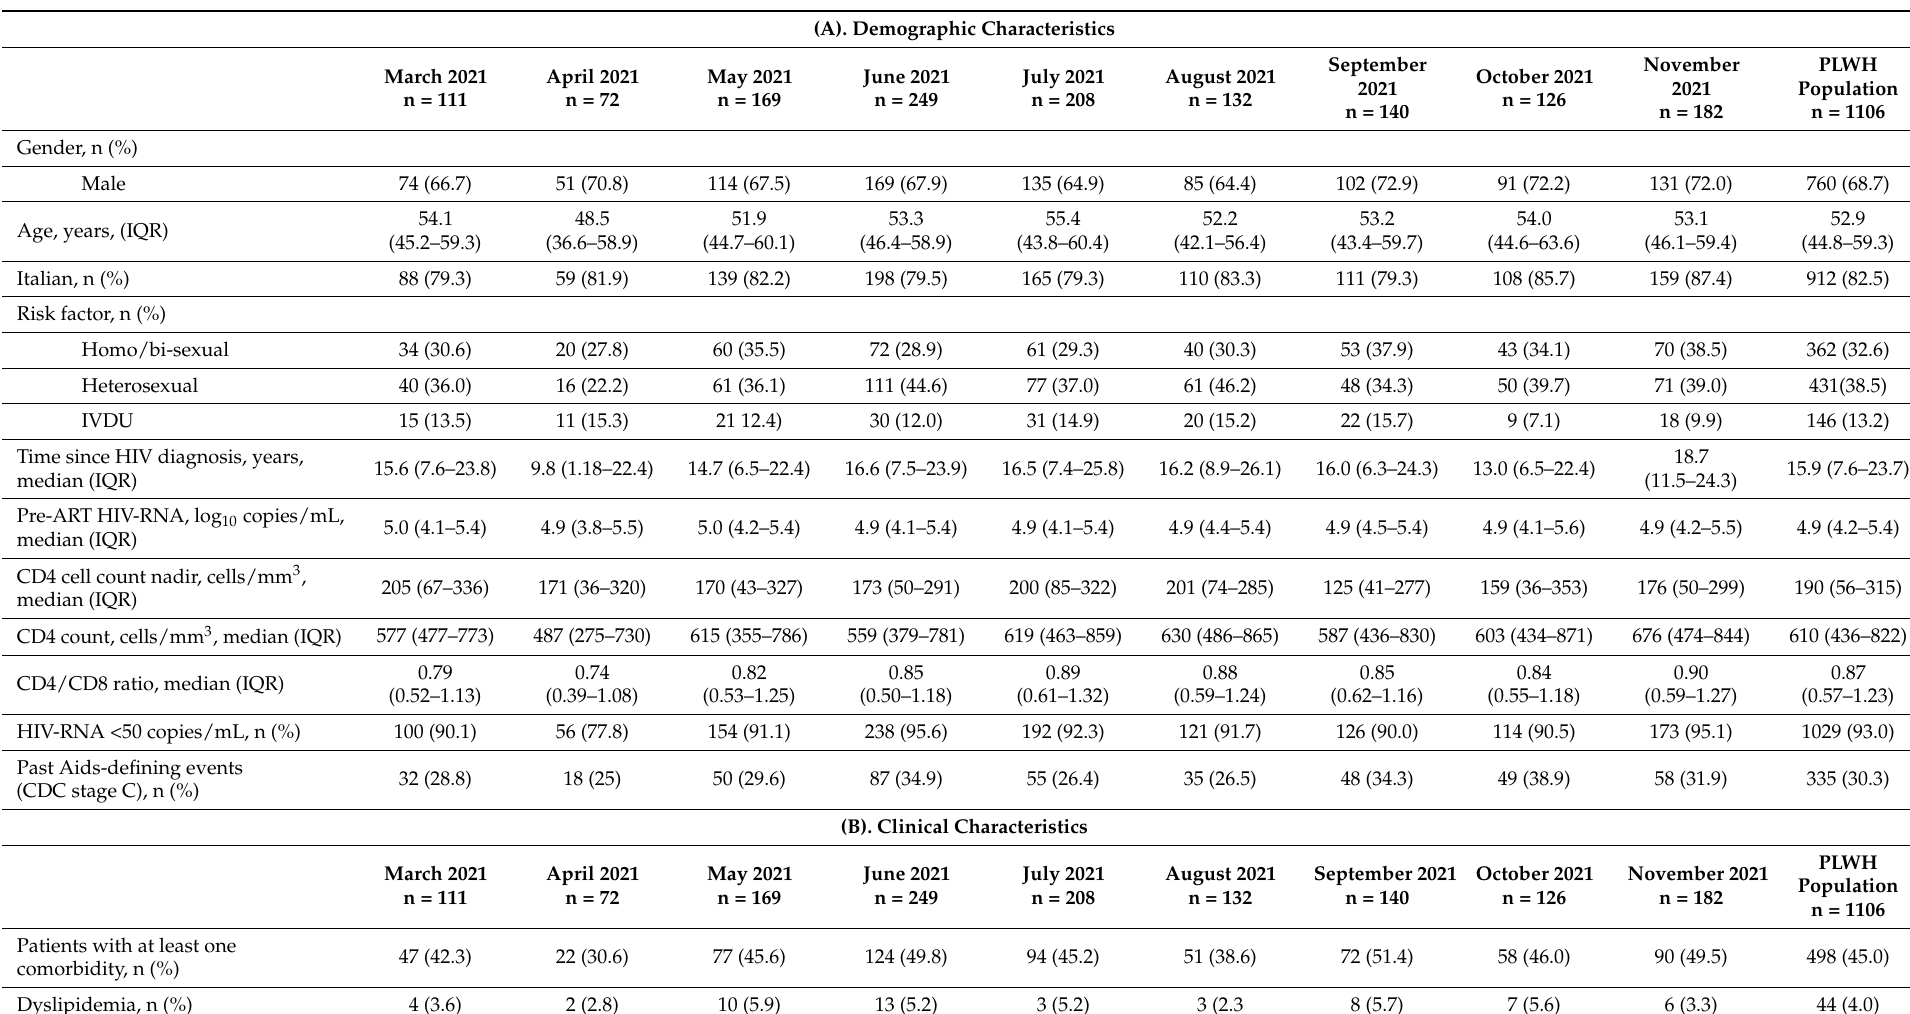
Table 1. Characteristics of the entire study samples (n = 1389) from HIV-infected patients (n = 1106) according to the month. (A). Demographic